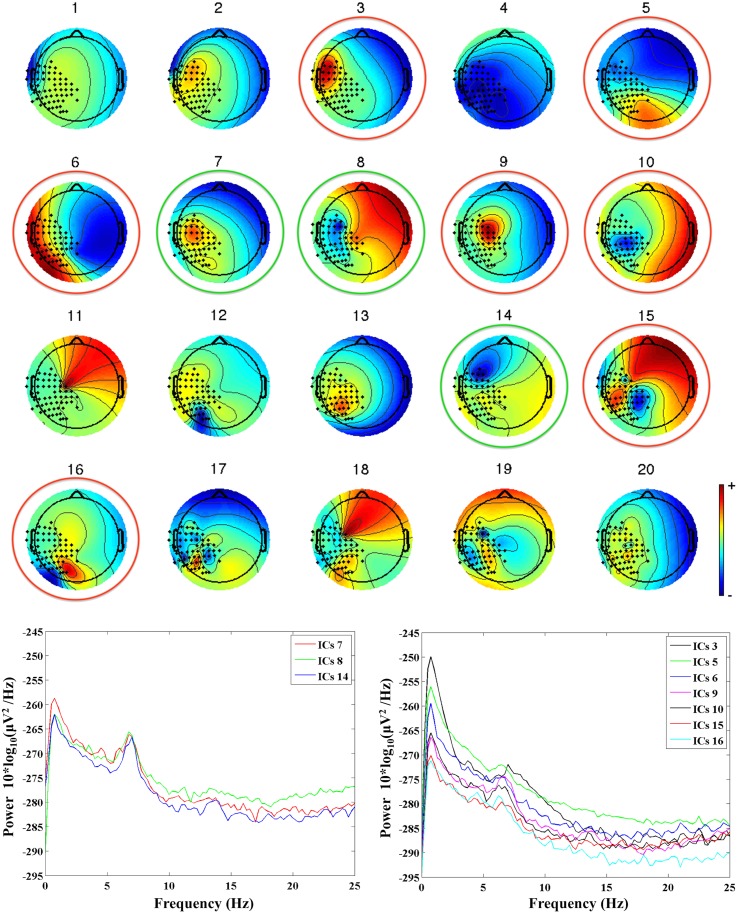
Upper panel: the 20 ICs separated from the MEG recordings in an infant at 36 weeks (G2, mu peak frequency at 7.5 Hz). The ICs retained for further analysis are identified by a green circle, whereas the rejected ICs are identified by a red circle. Lower panels: power spectra of the retained ICs (on the left hand side), and of the rejected ICs (on the right hand side).